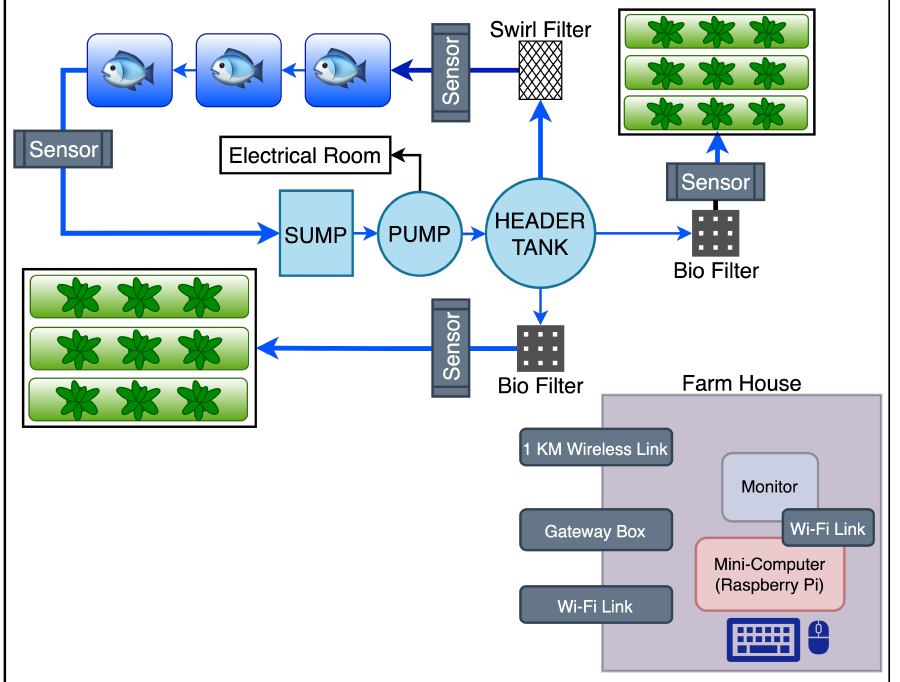
Figure 2. Simple aquaponics system floor